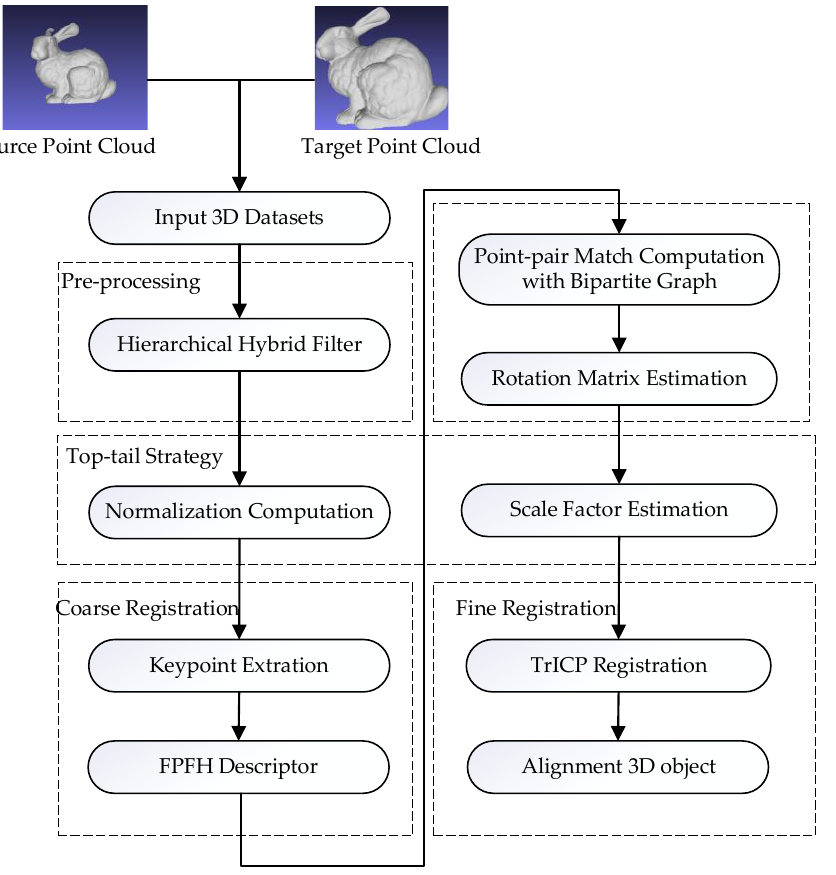
Figure 2. Architecture of the coarse-to-fine registration.